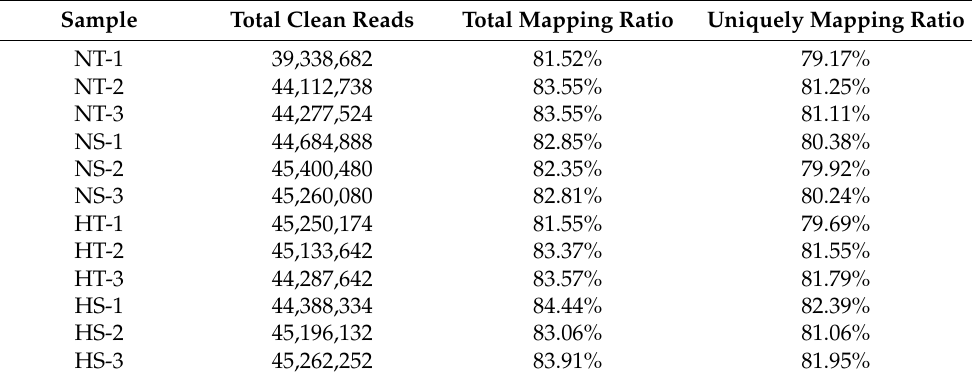
Table 2. Statistics of reads mapped onto tomato reference genomes.